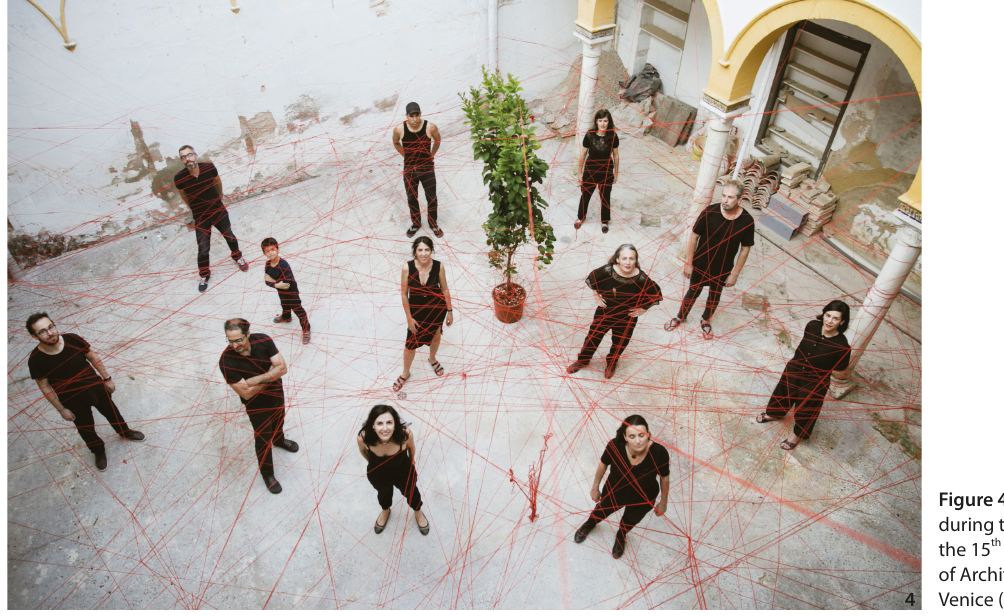
Figure 4 he PAX Team members during the installation done for the 15 th International Exhibition of Architecture. La Biennale of Venice (Source: Sergio